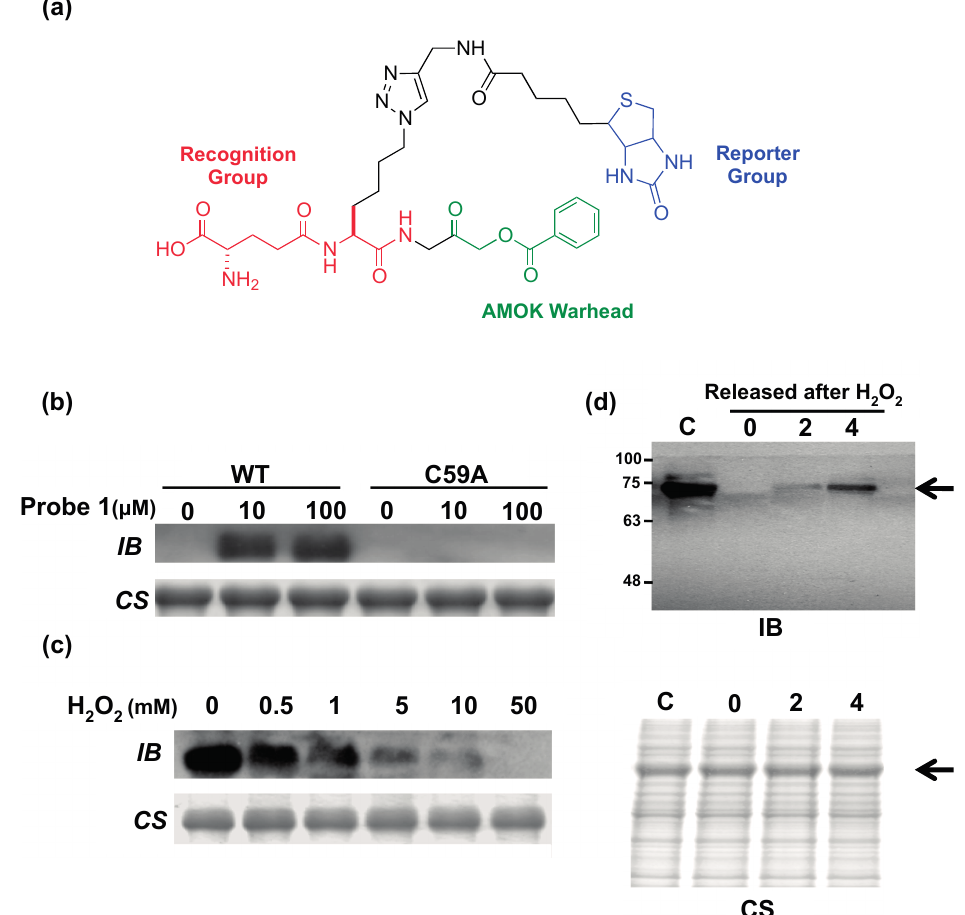
Figure 5. ( a ) Structure of an acyloxymethyl ketone (AOMK) activity-based probe (ABP) for the characterization of Gsp amidase in E. coli [49]. A typical ABP includes a warhead for covalent crosslinking (in color green), a domain to enhance binding selectivity (red), and a reporter group to allow for experimental characterization (blue); ( b ) Recombinant Gsp synthetase/amidase (GspSA, “WT”) and the mutant C59A could be distinguished by immunoblotting; ( c ) The extent of GspSA deactivation by H 2 O 2 could be differentially assayed; ( d ) GspSA could be specifically identified in vivo . Upon peroxide treatment, the amount of active Gsp amidase in E. coli cultures could be measured. The arrow identifies the expected position of GspSA (MW of 70 kDa). WT: wild-type GspSA; IB: immunoblotting using anti-biotin; CS: Coomassie Blue staining; C: negative control, no H 2 O 2 treatment. Lanes marked 0, 2, 4, denote the duration of recovery (h) after H 2 O 2 release [49]. ©